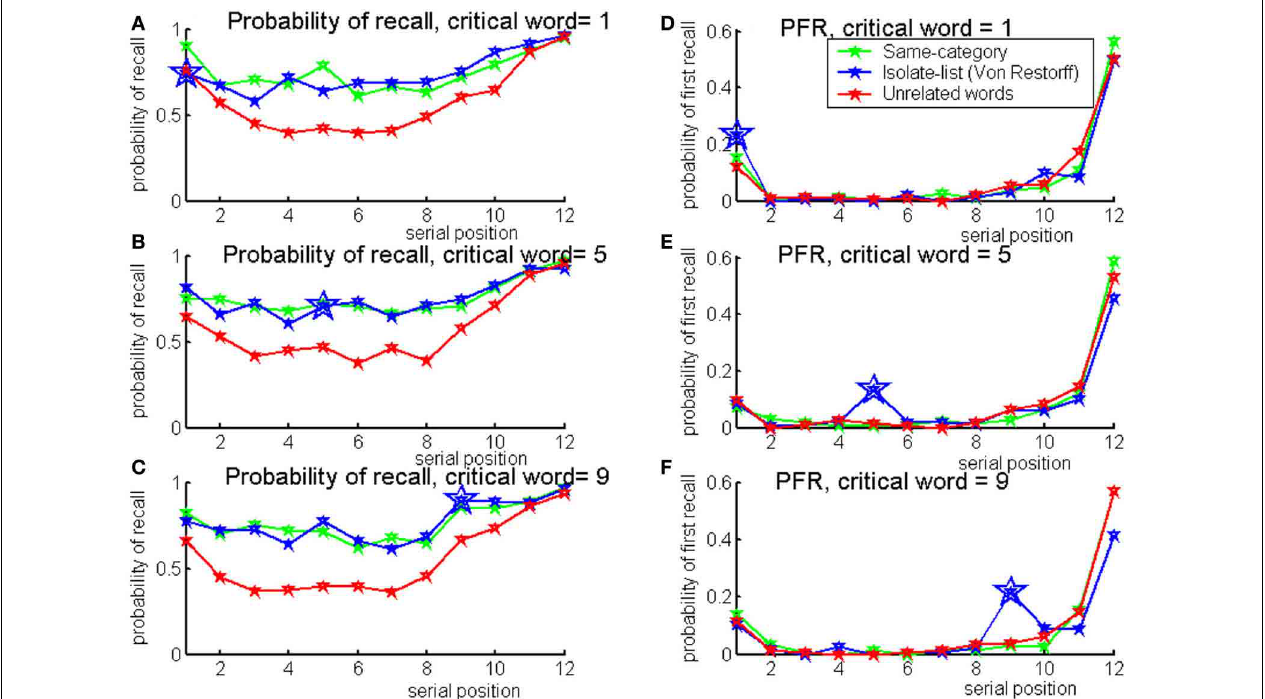
FIGURE 11 | Probability of recall (left) and probability of first recall (right) for lists with critical words at positions: 1 (top), 5 (middle), and 9 (bottom). In all panels, same-category lists are illustrated in green, isolate